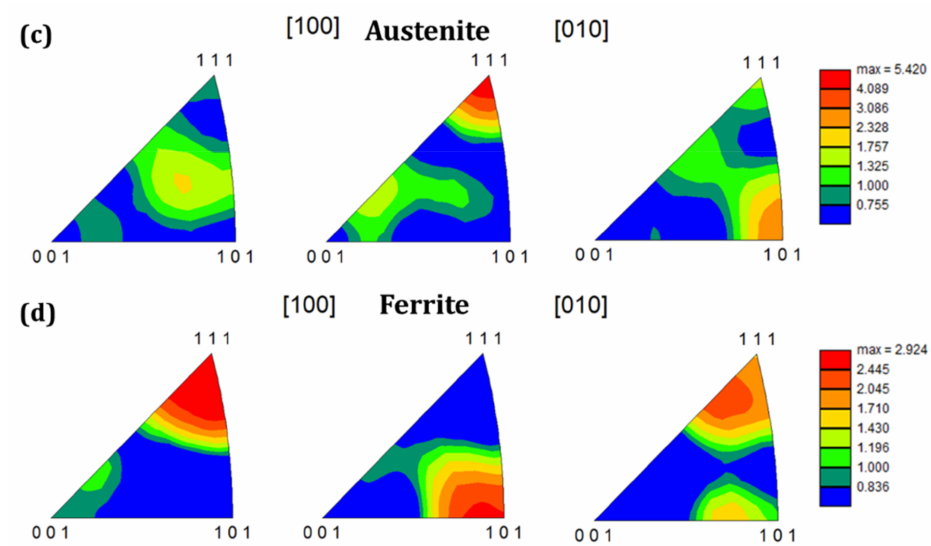
Figure 4. Pole figure and inverse pole figure ( a , c ) of the austenite phase; and ( b , d ) ferrite phase.